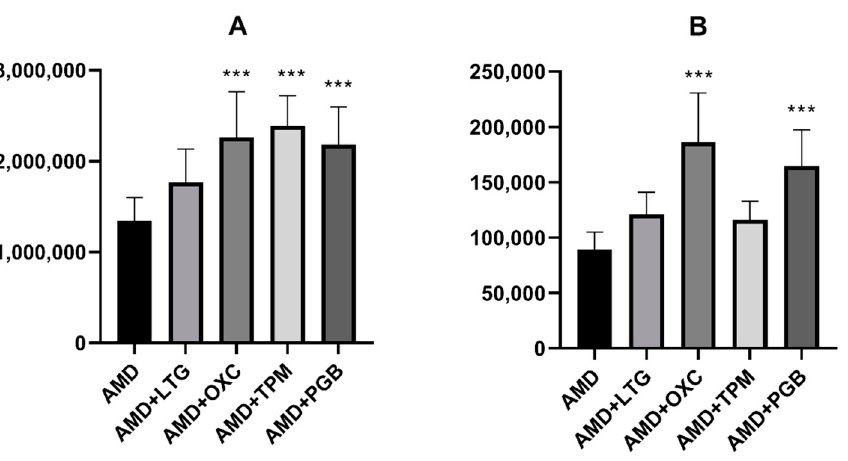
Figure 3. Effects of acute administration of antiepileptic drugs on the brain concentration of ( A ) amiodarone and ( B ) desethylamiodarone. Data are presented as the means ± SD of the peak area of at least eight determinations. Statistical analysis was performed using one-way analysis of variance (ANOVA) followed by the post hoc Dunett’s test. AMD—amiodarone, DEA—desethylami ‐ odarone, LTG—lamotrigine, OXC—oxcarbazepine, TPM—topiramate, PGB—pregabalin, *** p < 0.001 vs. control group.